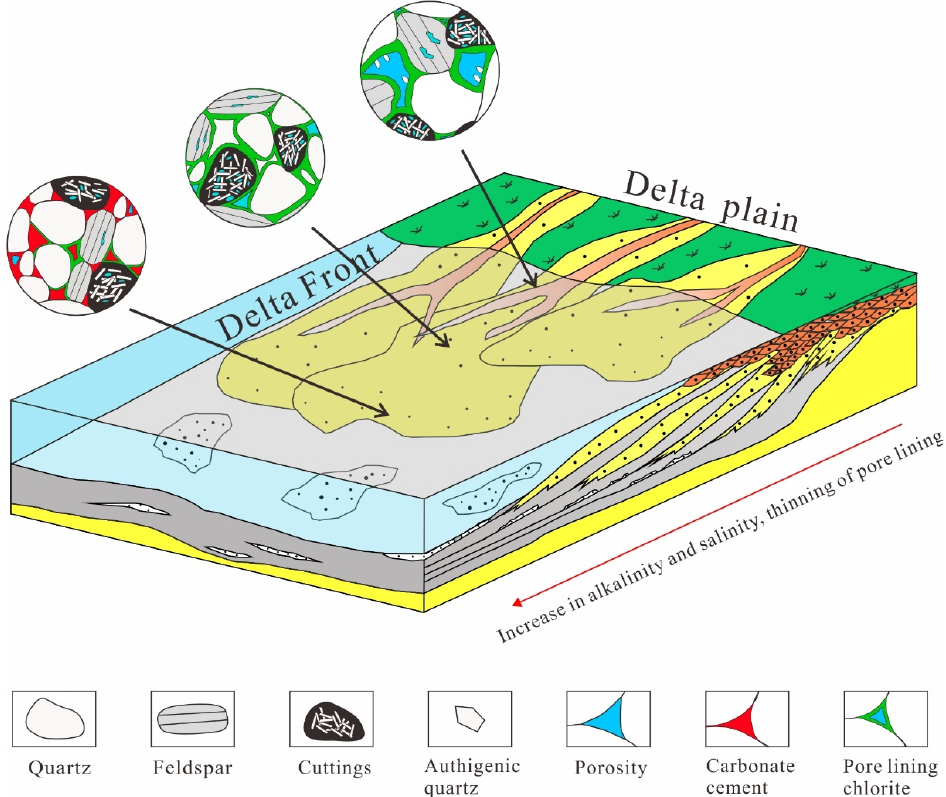
Figure 10. Relationship between authigenic chlorite and sedimentary environment (modified from [24]). The entrance of the lake is a high-energy, open, weakly alkaline reducing environment. The iron in the river flocculates due to the difference in salinity at the entrance of the lake. Under strong hydrodynamic conditions, clay minerals adhere to the surfaces of the particles to form pore-lining chlorite. As the water depth increases, the alkalinity and reducibility increase, the hydrodynamic conditions weaken, the pore-lining chlorite becomes thinner, and the carbonate cement precipitates from the pore fluid.